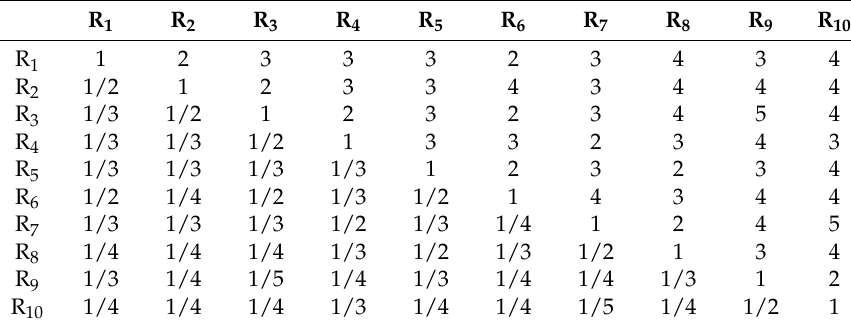
Table 4. Initial pairwise comparison matrix.